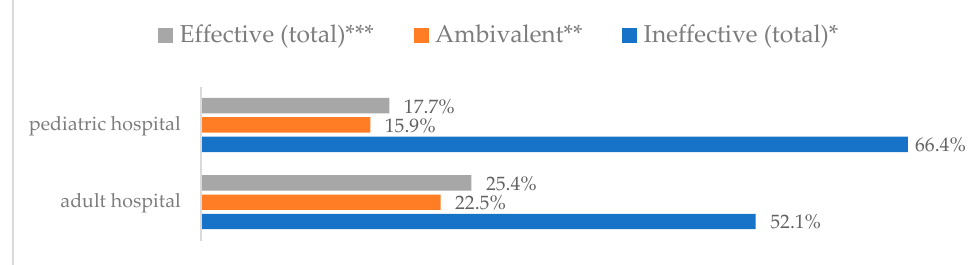
Figure 33. Taking vitamin C daily to prevent influenza virus infection by type of hospital ( N = 905). *Sum of responses: completely ineffective, ineffective, rather ineffective; **Response: neither ineffective nor effective; ***Sum of responses: rather effective, effective, completely effective.